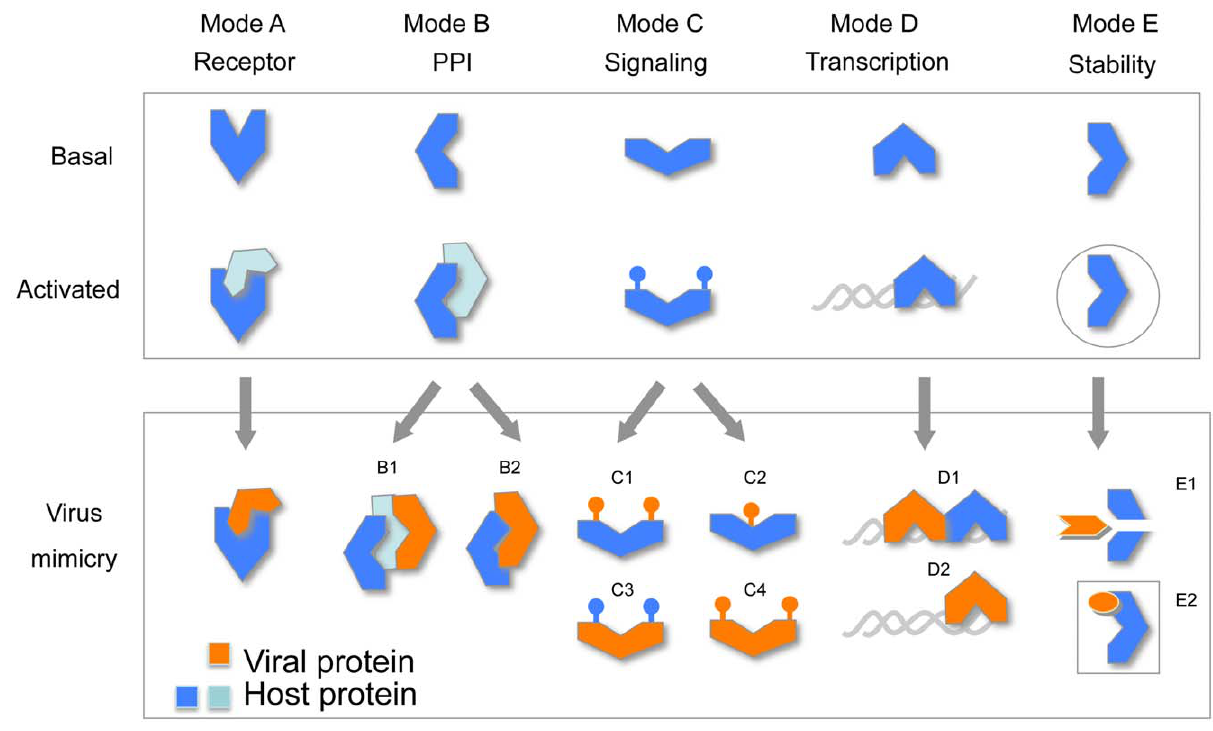
Figure 7. Representative strategies carried on by viral proteins acquired sequences from the hosts. The schematic modes of action (A– E) for the mimics by viral sequences are shown. The host protein (blue) and the protein-activated stage (orange) are illustrated in the top panel. Viral proteins that contain sequences that originated from the hosts may alter the host’s cell through several strategies marked A1–E2. A fundamental principle is a competition with the native proteins (Modes A, B), an alteration by modifications of a target protein (Mode C), the ability to override the transcription program (Mode D) and the impact on the integrity of the target protein and the underlying cell biological processes (Mode E). The frame around the protein (in E) indicates a sub-cellular localization. See text for